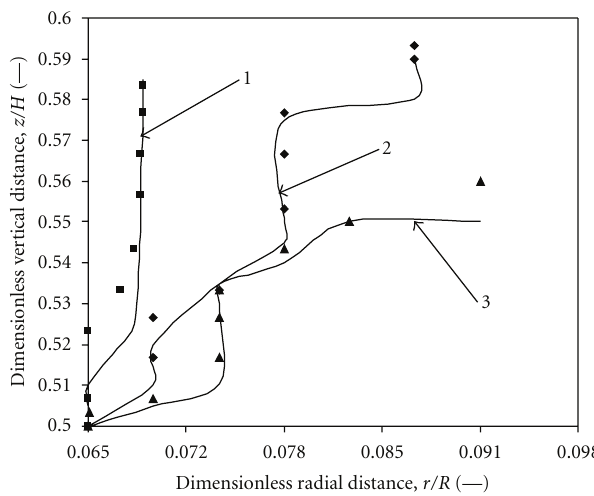
Figure 8: Dimensionless vertical distance v/ s, Dimensionless radial